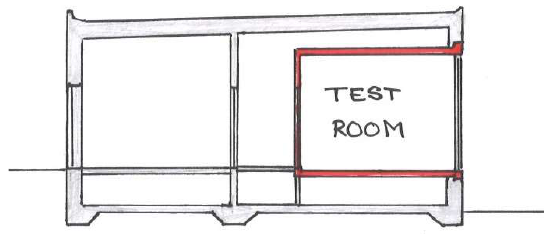
Figure 3. Schematic section of the test room at the EBD-lab.